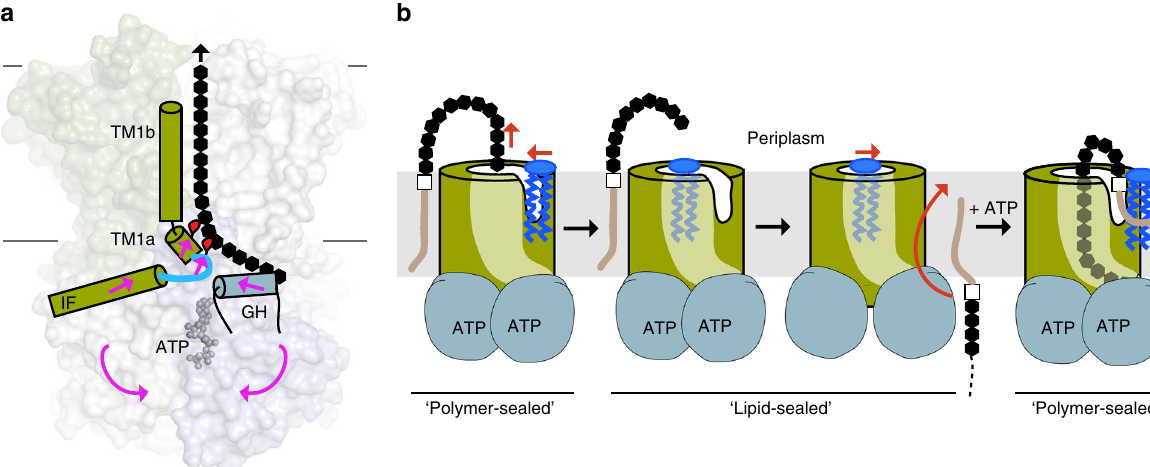
Fig. 6 Model of O antigen membrane translocation. a Upon ATP binding and NBD closure, the cytosolic gate helix (GH) pushes against the LG loop connecting Wzm ’ s IF and TM1. This movement correlates with the bending of TM1 and upward movement of TM1a. Conserved hydrophobic residues (Leu23 and Trp27, red ovals) interact with and push the polysaccharide chain into the transmembrane channel. b Membrane lipids gate the WzmWzt channel. Concomitant with the fi nal translocation step that releases the polysaccharide into the periplasm, lipid molecules diffuse into the channel to form a hydrophobic plug. This plug is replaced by the substrate upon insertion of a new lipid-linked O antigen into the channel. The substrate ’ s lipid moiety is released into the periplasmic membrane lea fl et through the lateral exit, which also allows lipid diffusion as a gating mechanism. The substrate is shown as a brown line connected to a white square for UndPP and black hexagons for the O by the channel ’ s lateral exit within the periplasmic bilayer lea fl et (Fig. 6). The negative membrane potential likely contributes to the reorientation of the negatively charged UndPP head-group to the periplasmic side, while also preventing its backsliding, from the periplasmic to the cytosolic side.